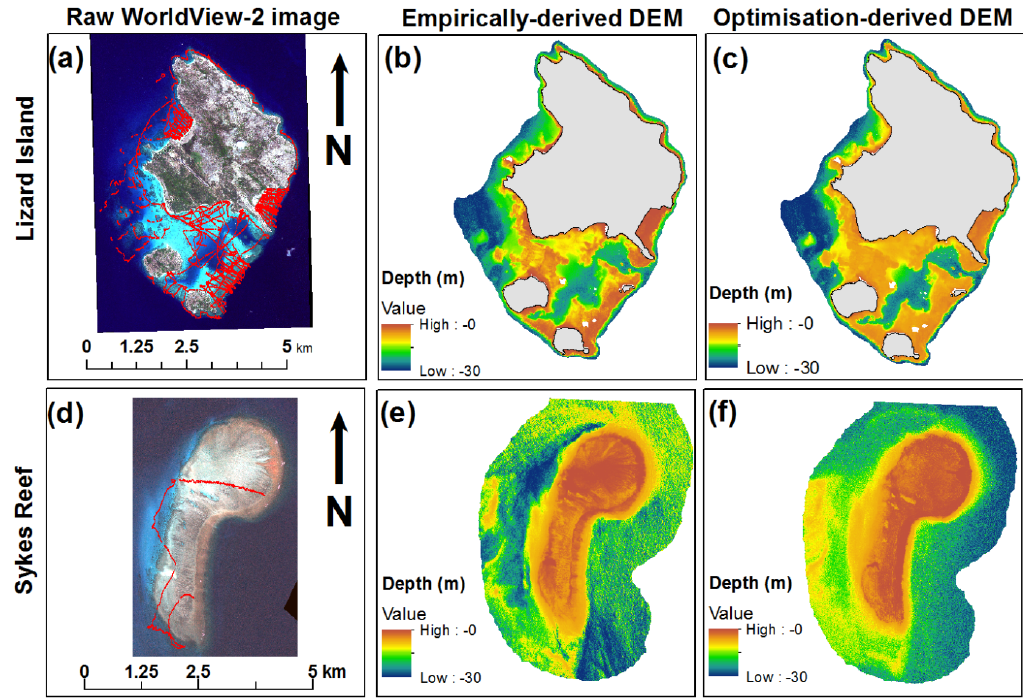
Figure 2. Raw satellite images and bathymetry estimates for study sites (from left to right, top to bottom): ( a ) WorldView-2 image of Lizard Island; ( b ) Empirically-derived bathymetry model for Lizard Island; ( c ) Optimisation-derived bathymetry model for Lizard Island; ( d ) WorldView-2 image of Sykes Reef; ( e ) Empirically-derived bathymetry model for Sykes Reef; ( f ) Optimisation-derived bathymetry model for Sykes Reef.